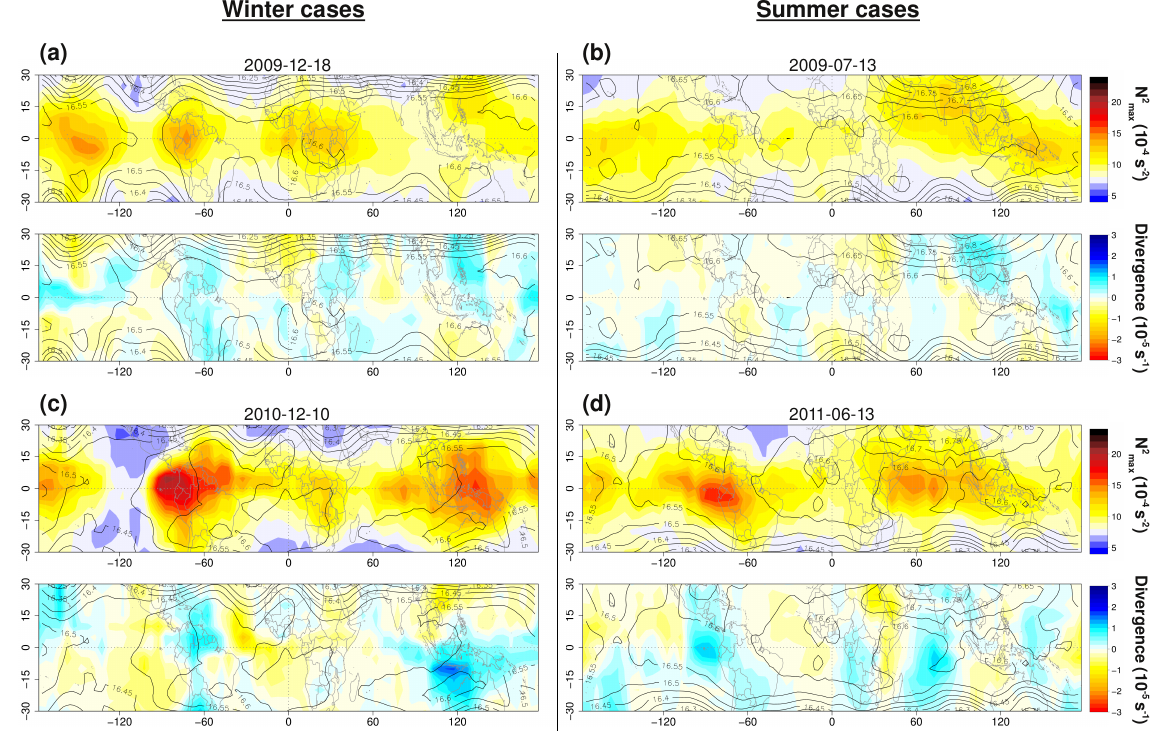
Figure 2. Maps of daily TIL strength ( N 2 max , first and third rows) and 100hPa horizontal wind divergence (second and fourth rows). Winter cases are on the left side and summer cases are on the right side. Corresponding color scales are on the right end. Contour lines show the 100hPa geopotential height (in kilometers with 50m